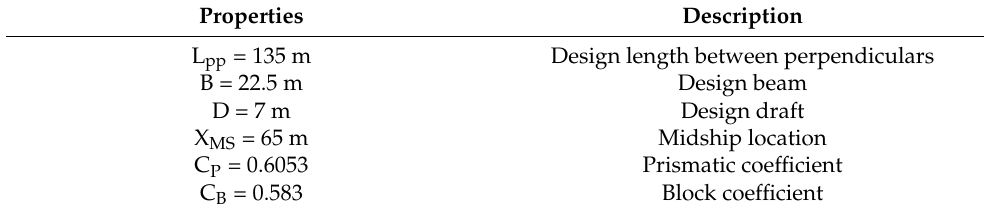
Table 2. Main dimension of the Ro-Ro